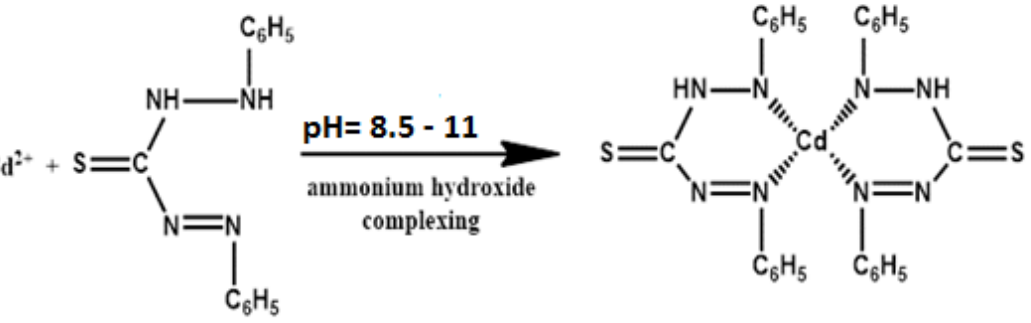
Figure 1. Cadmium dithizone complex.